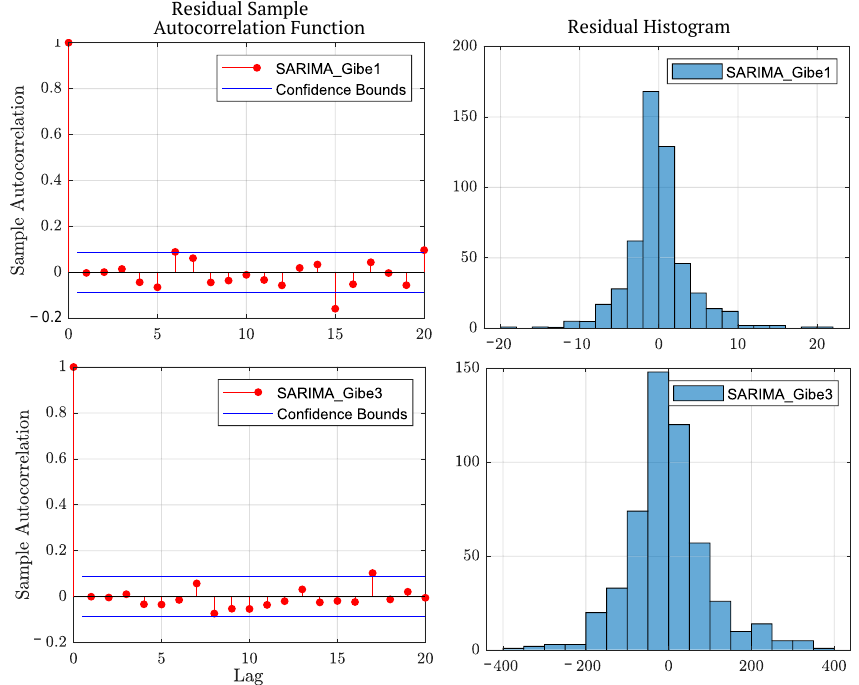
Figure 6. Residual diagnosis of the weekly time